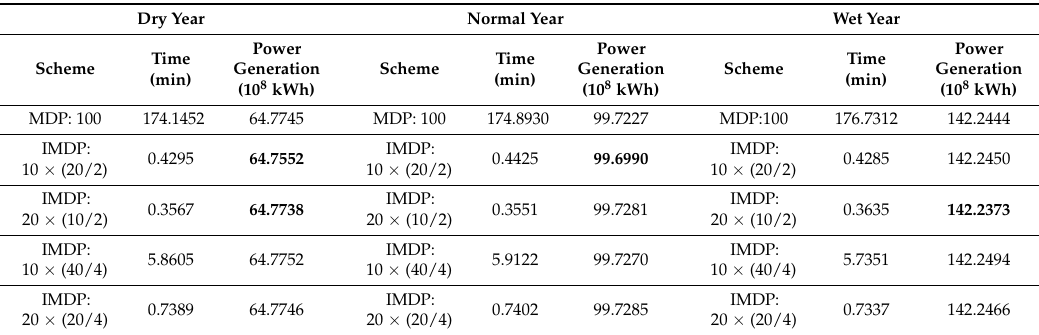
Table 7. Results of MDP and IMDP.